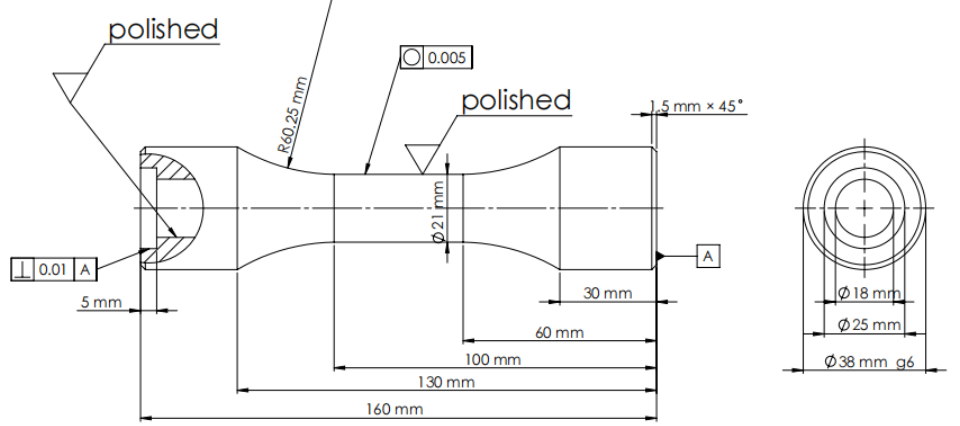
Figure 4. The dimensions of the fatigue specimen.